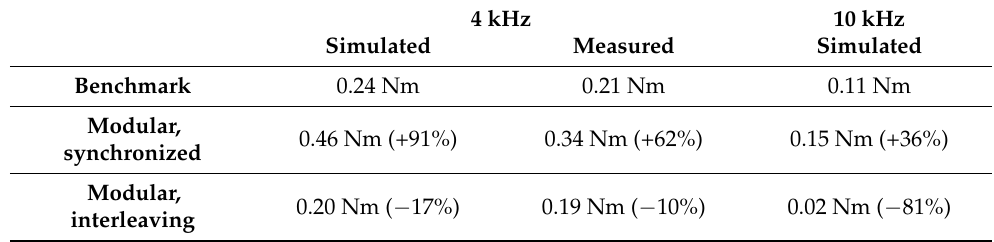
Table 3. Torque ripple amplitude at the resonance mode comparing simulations with a PWM switching frequency of 4 and 10 kHz with measurements at a PWM switching frequency of 4